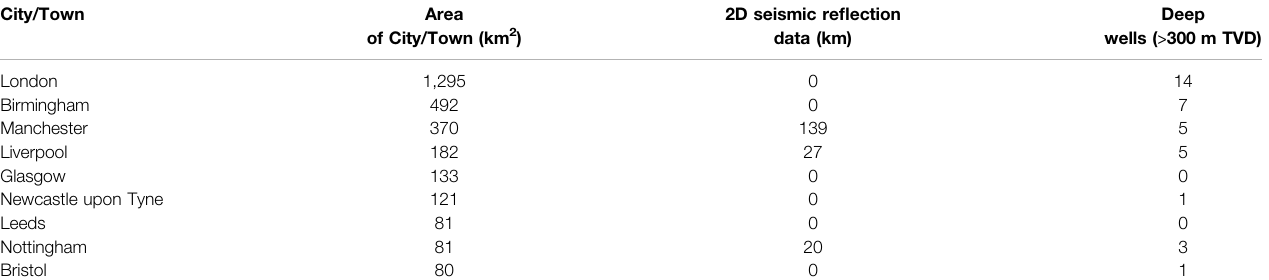
TABLE3| Datacoveragefor10largestareasofannualdomesticheatdemandabove10,000 MWh/km2.Bothextentof2Dseismicre fl ectiondataandnumberofdeepwells are quanti fi ed within these areas. See Figure 7 for map view of London, Birmingham, Manchester and Liverpool.